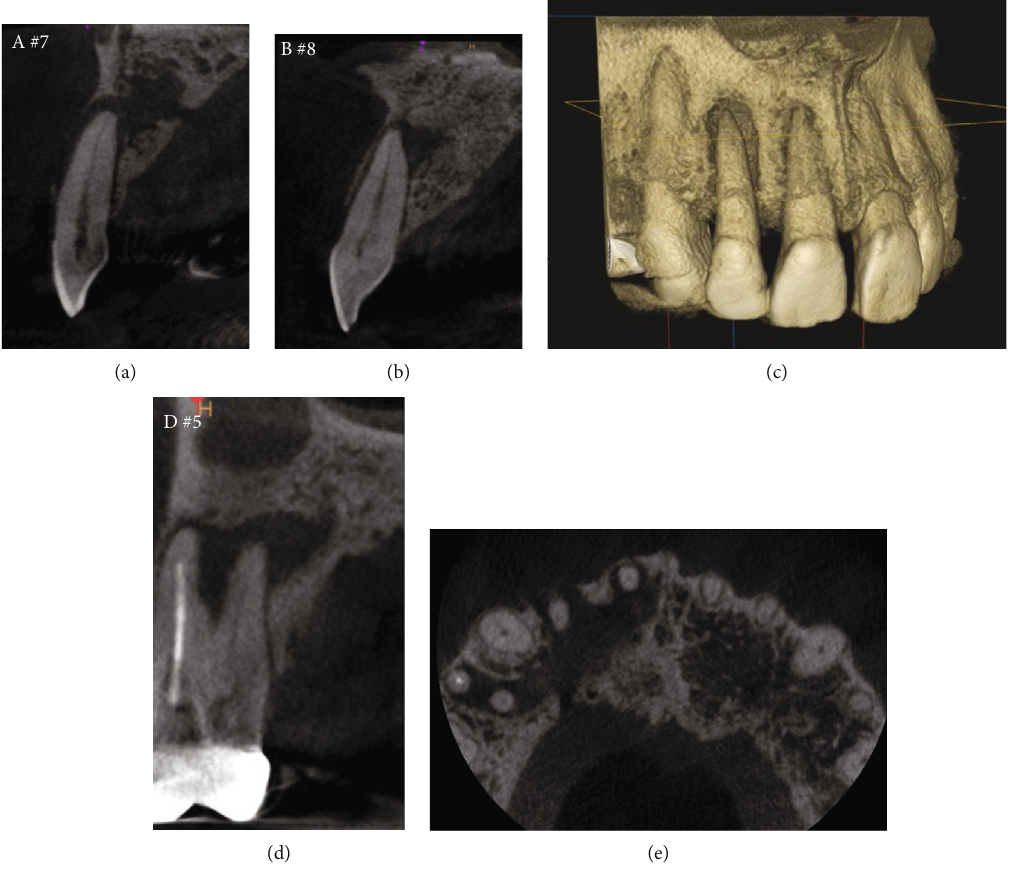
Figure 2: Preoperative CBCT images. Hypodense regions were seen around the apexes of the central and lateral incisors (a, b). Marked apical bone resorption around the lateral incisor (a, c). The palatal root canal of the fi rst premolar was untreated and an apical lesion was observed (d). The apical lesion of the maxillary right fi rst premolar had extensively spread in the anterior direction from the palatal side, destroyed the bone by circumventing the palatal side of the adjacent canine, and reached the apical areas of central and lateral incisors